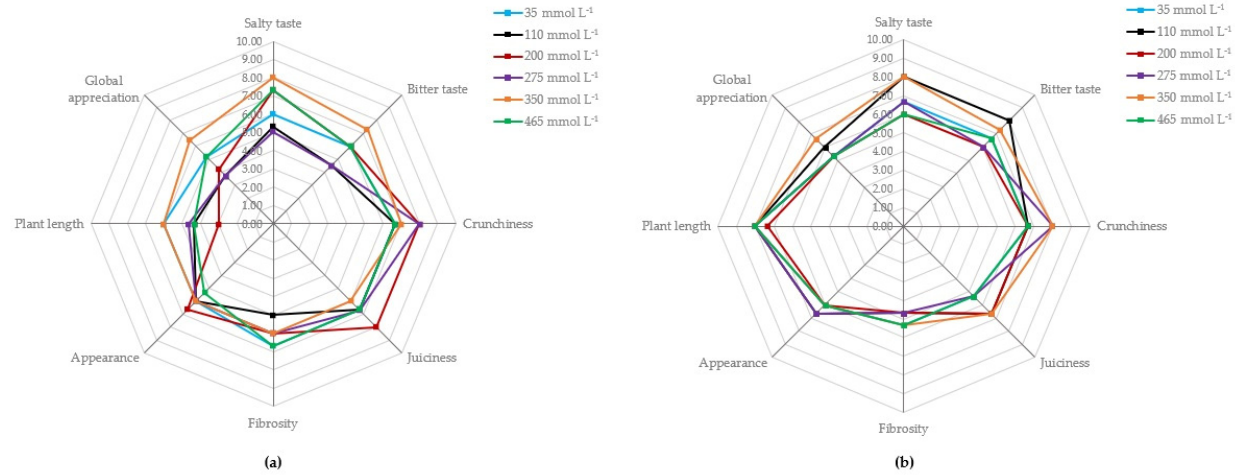
Figure 3. Visual display of the sensory attributes based on the results of the QDA test for I. crithmoides ( a ) and M. nodiflorum ( b ) cultivated at six different salinities. For each attribute, the ranking increases as it moves farther away from the central point.